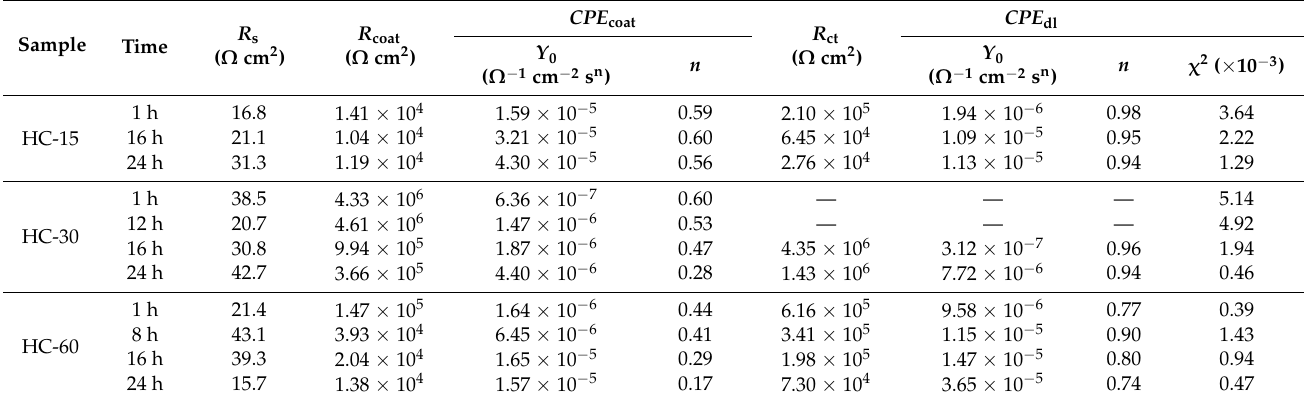
Table 3. The elements parameters of EIS fitted by the equivalent